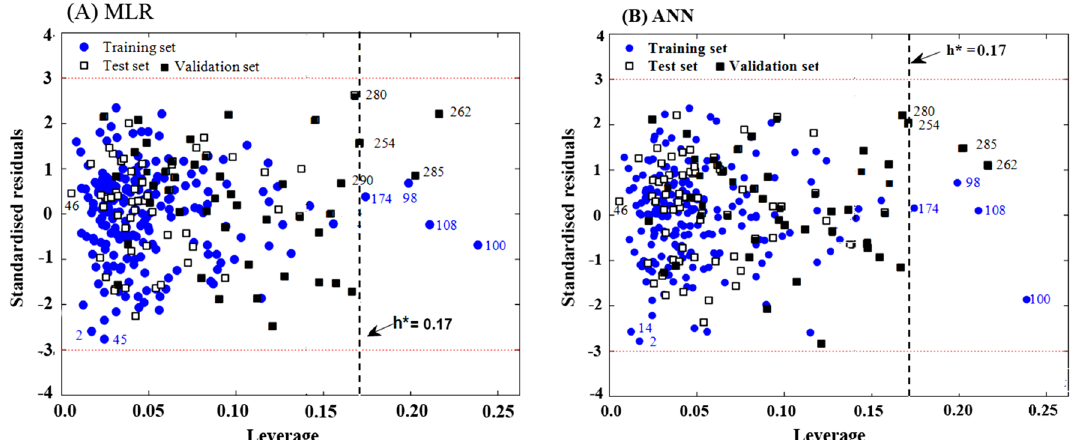
Figure 4. Williams plots-based analyses to compare training, test, and validation sets during the MLR and ANN models development on the PI3Kγ